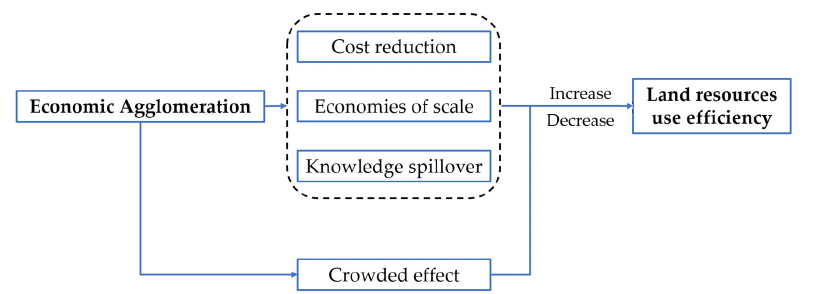
Figure 1. Influencing path of economic agglomeration on land resource use efficiency. Hypothesis 1. LRUE has spillover effects